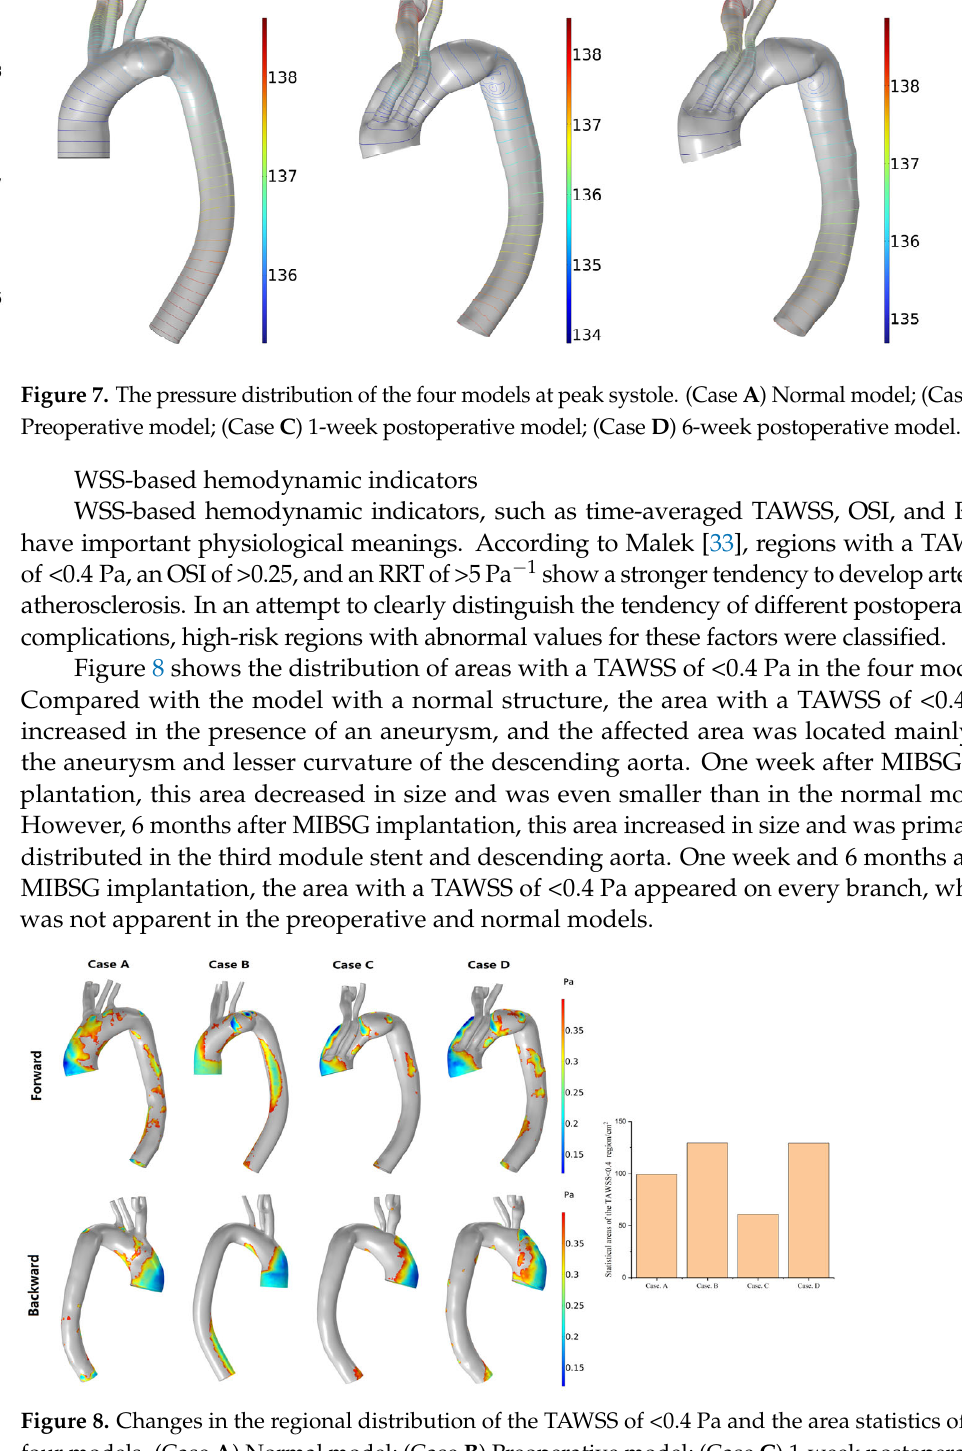
Figure 8. Changes in the regional distribution of the TAWSS of <0.4 Pa and the area statistics of the four models. (Case A ) Normal model; (Case B ) Preoperative model; (Case C ) 1-week postoperative model; (Case D ) 6-week postoperative model.